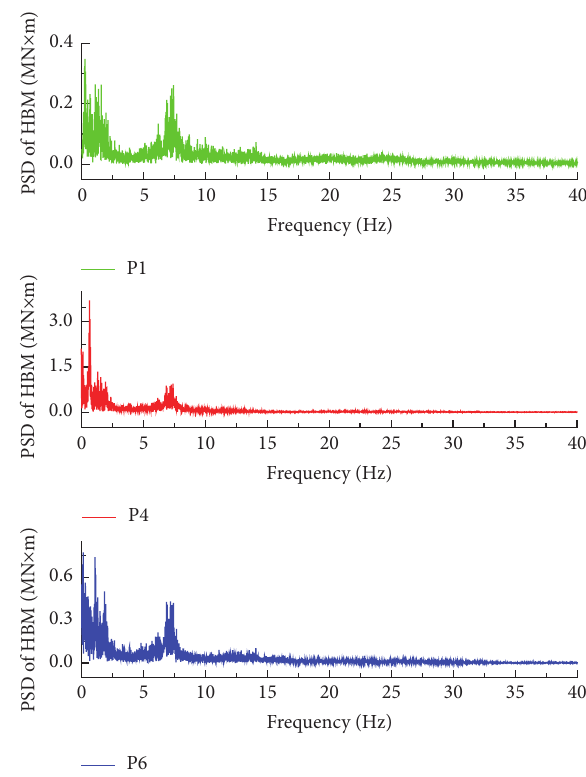
Figure 29: Power spectral density functions of HBM.